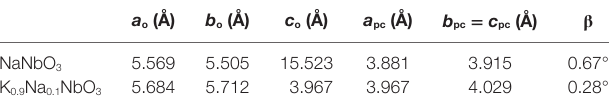
Table 1 | Orthorhombic (index “o”) and pseudocubic (index “pc”) lattice parameters together with the monoclinic distortion angle β for NaNbO 3 and K 0.9 Na 0.1 NbO 3 .